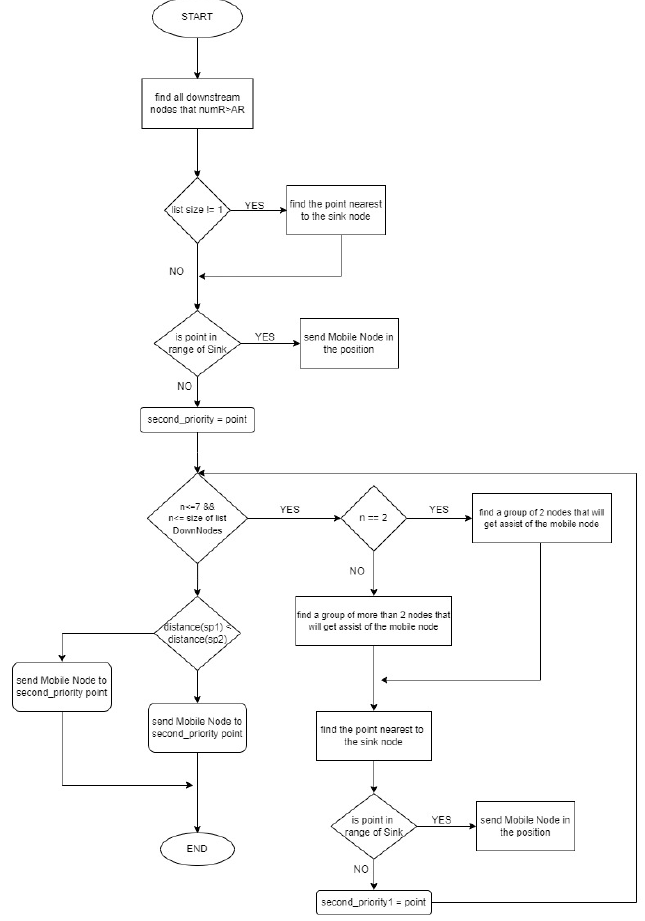
Figure A1. Dynamic MobileCC Flowchart.